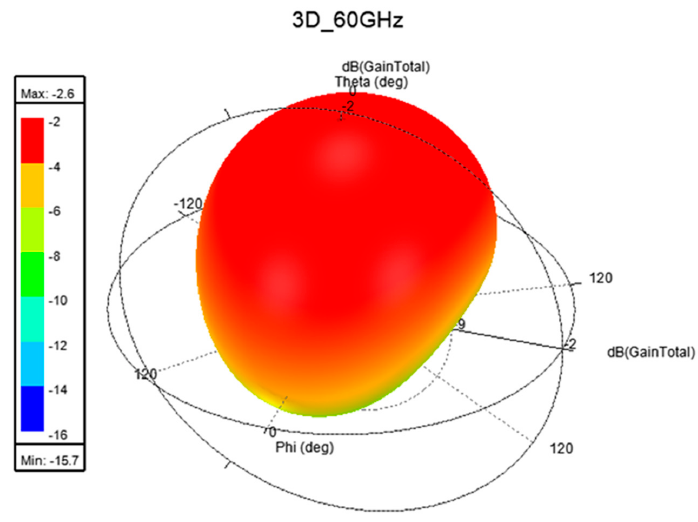
Figure 24. 2D field simulation at 60GHz: ( a ) yz plane; ( b ) xz plane.